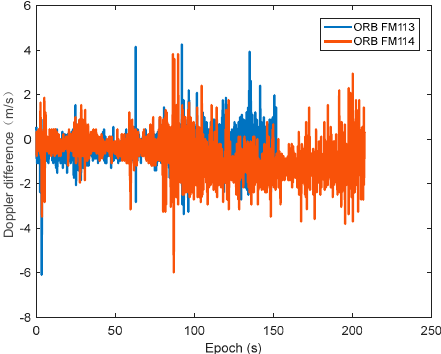
Figure 9. Orbcomm measured Doppler single difference.